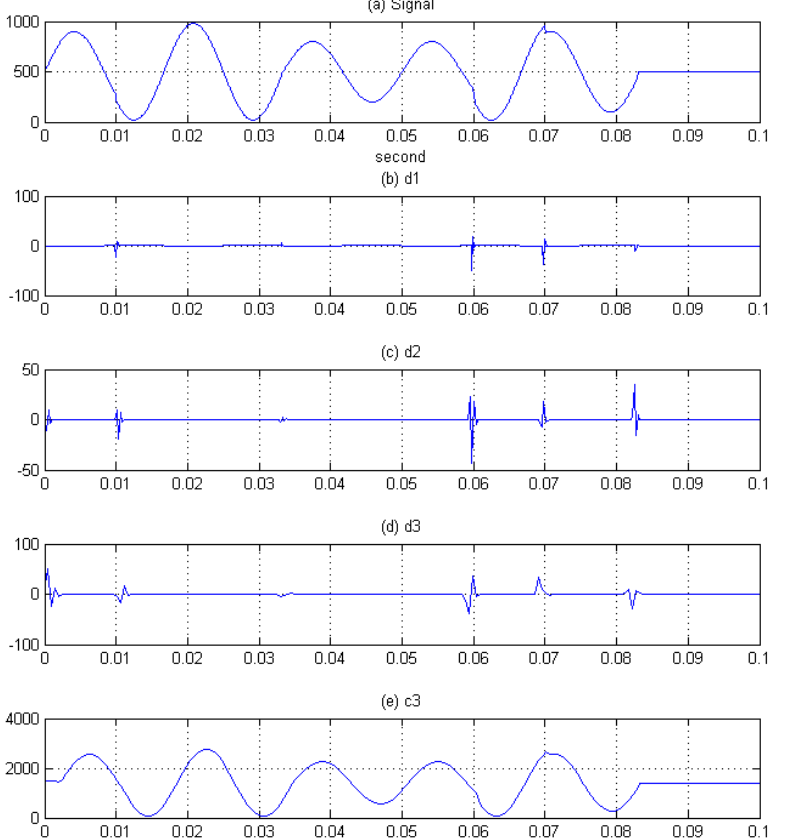
Figure 3. ( a ) Distorted power signal, ( b ) signal of wavelet coefficient d 1 , ( c ) signal of wavelet coefficient d 2 , ( d ) signal of wavelet coefficient d 3 , and ( e ) signal of scaling coefficient c 3 .